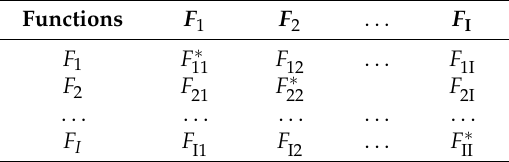
F . . . F 11 12 1I F ∗ F 22 2I 21 F . . . F ∗ I2 I1